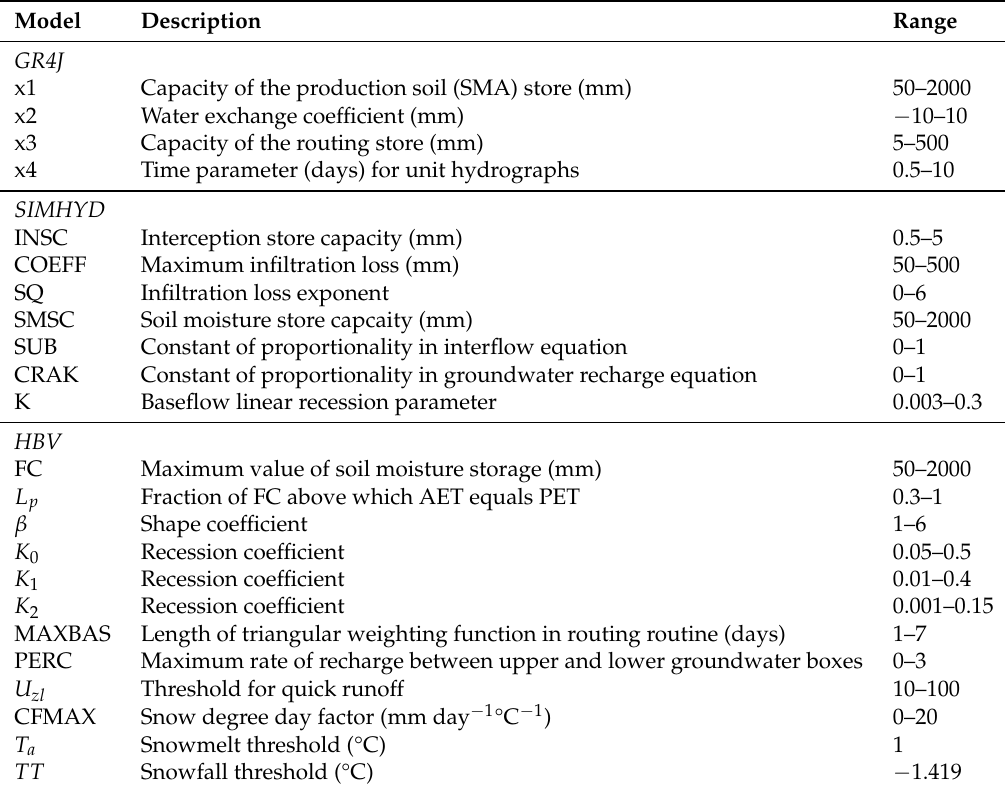
Table A1. Model parameters, definition and range used in the